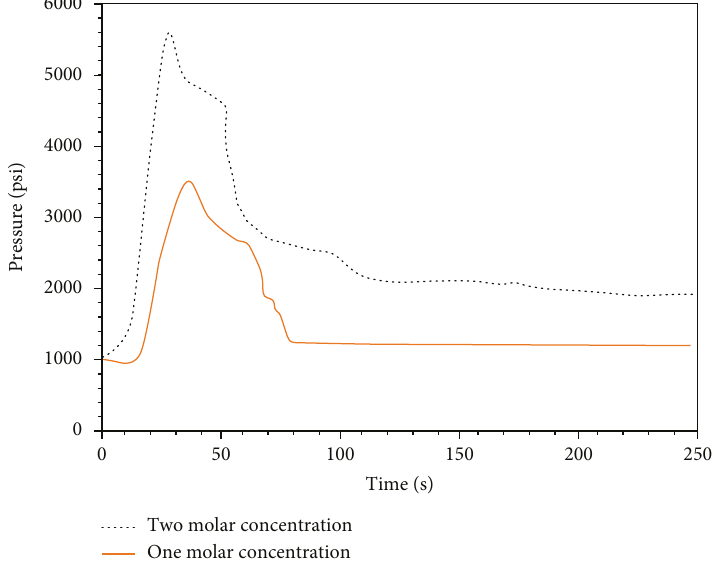
Figure 9: Generation of pressure pulse due to thermochemical reaction, e ff ect of reactant molar concentration.